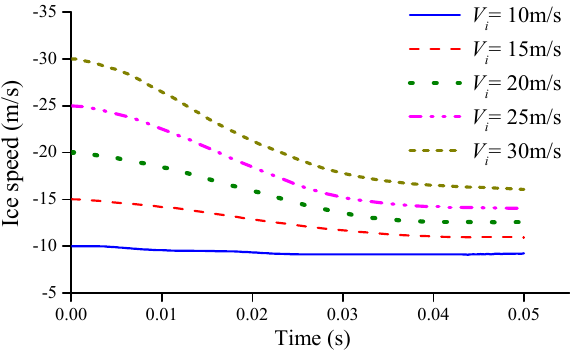
Figure 22. Time series of ice speed in the x direction based on simulations with di ff erent ice initial speeds.